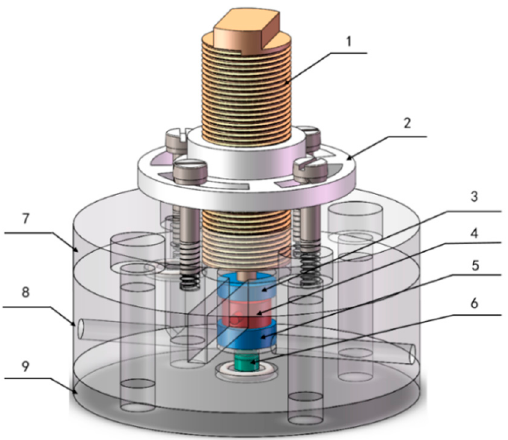
Figure 13. Test bench, (1) piezoelectric actuator; (2) fixed disc; (3) cylinder 1; (4) force sensor; (5) cylinder 2; (6) testing object; (7–9) base.